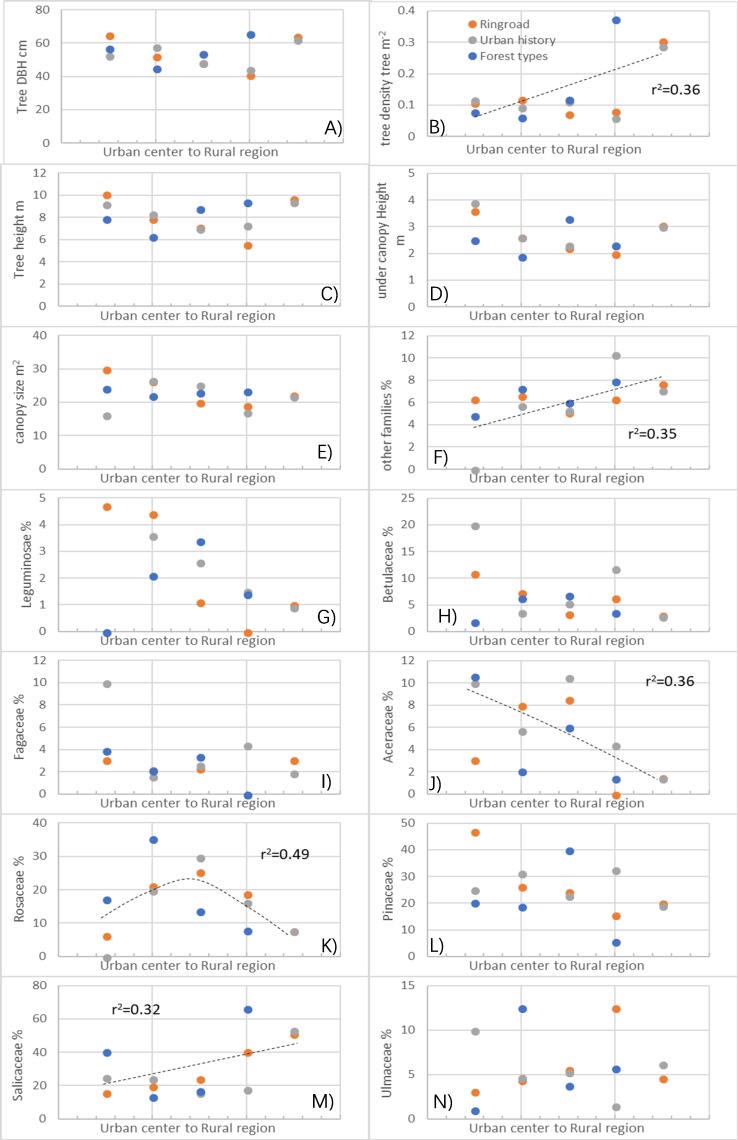
Differences in forest characteristics (i.e., tree sizes, density and compositional traits) where the microclimate regulation by trees was measured in different urban-rural regions.(A) Tree diameter; (B) tree density; (C) tree height; (D) under canopy height; (E) canopy size; (F) other family percentage in the forests; (G) Leguminosace percentage in the forests; (H) Betulaceae percentage in the forests; (I) Fagaceae percentage in the forests; (J) Aceraceae percentage in the forests; (K) Rosaceae percentage in the forests; (L) Pinaceae percentage in the forests; (M) Saliaceae percentage in the forests; (N) Ulmaceae perccentage in the forests. Dashed lines in the figures indicate significant changes in the regression analysis (p < 0.05).